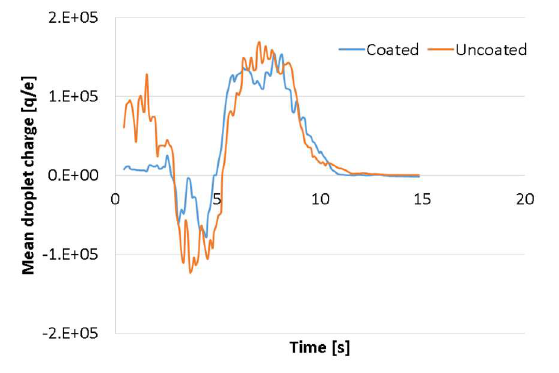
Fig. 7. Small droplet mean elementary charge